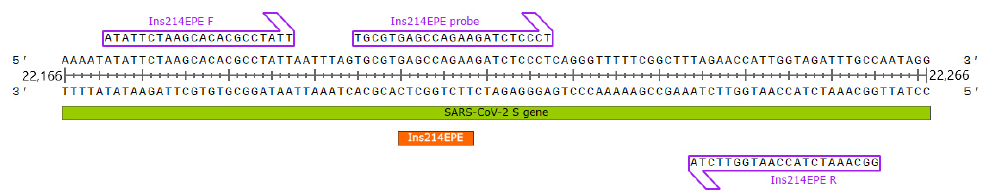
Figure 1. 2-SARS-CoV-2-ORF-1 oligonucleotides binding scheme.